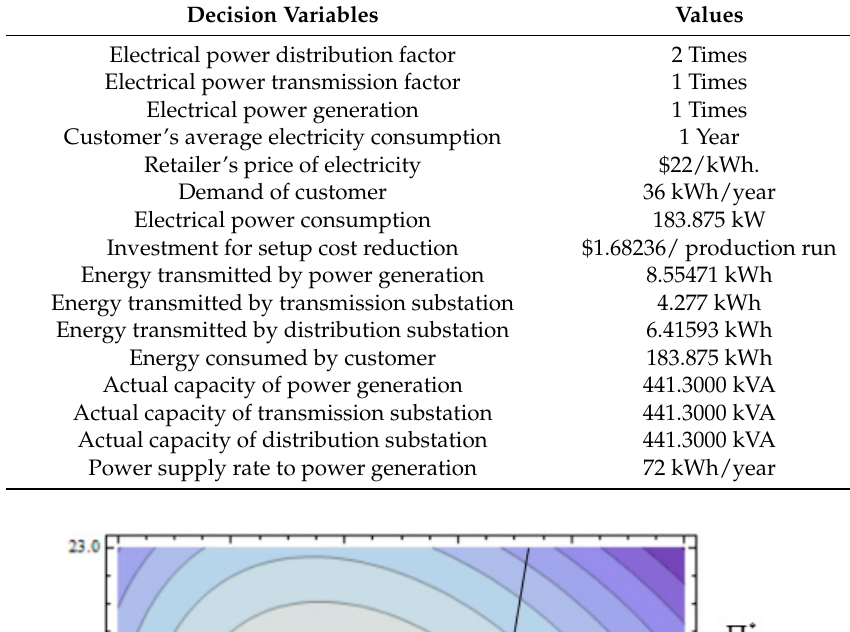
Table 4. The results.